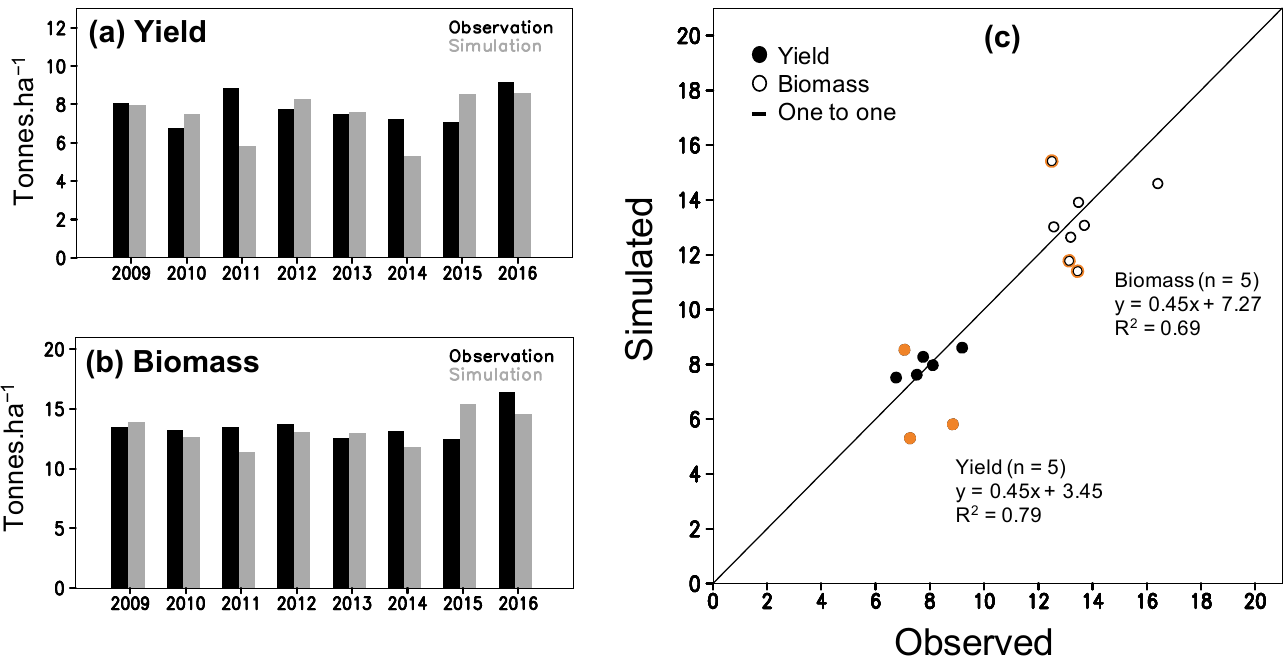
Figure 4. ORYZA(v3) model validation by using experiment data from 2009–2016; observed and simulated ( a ) yield, and ( b ) total above ground biomass; panel ( c ) shows scatter plots for yield and biomass (orange ‐ circle marks are 2011, 2014 and 2015).